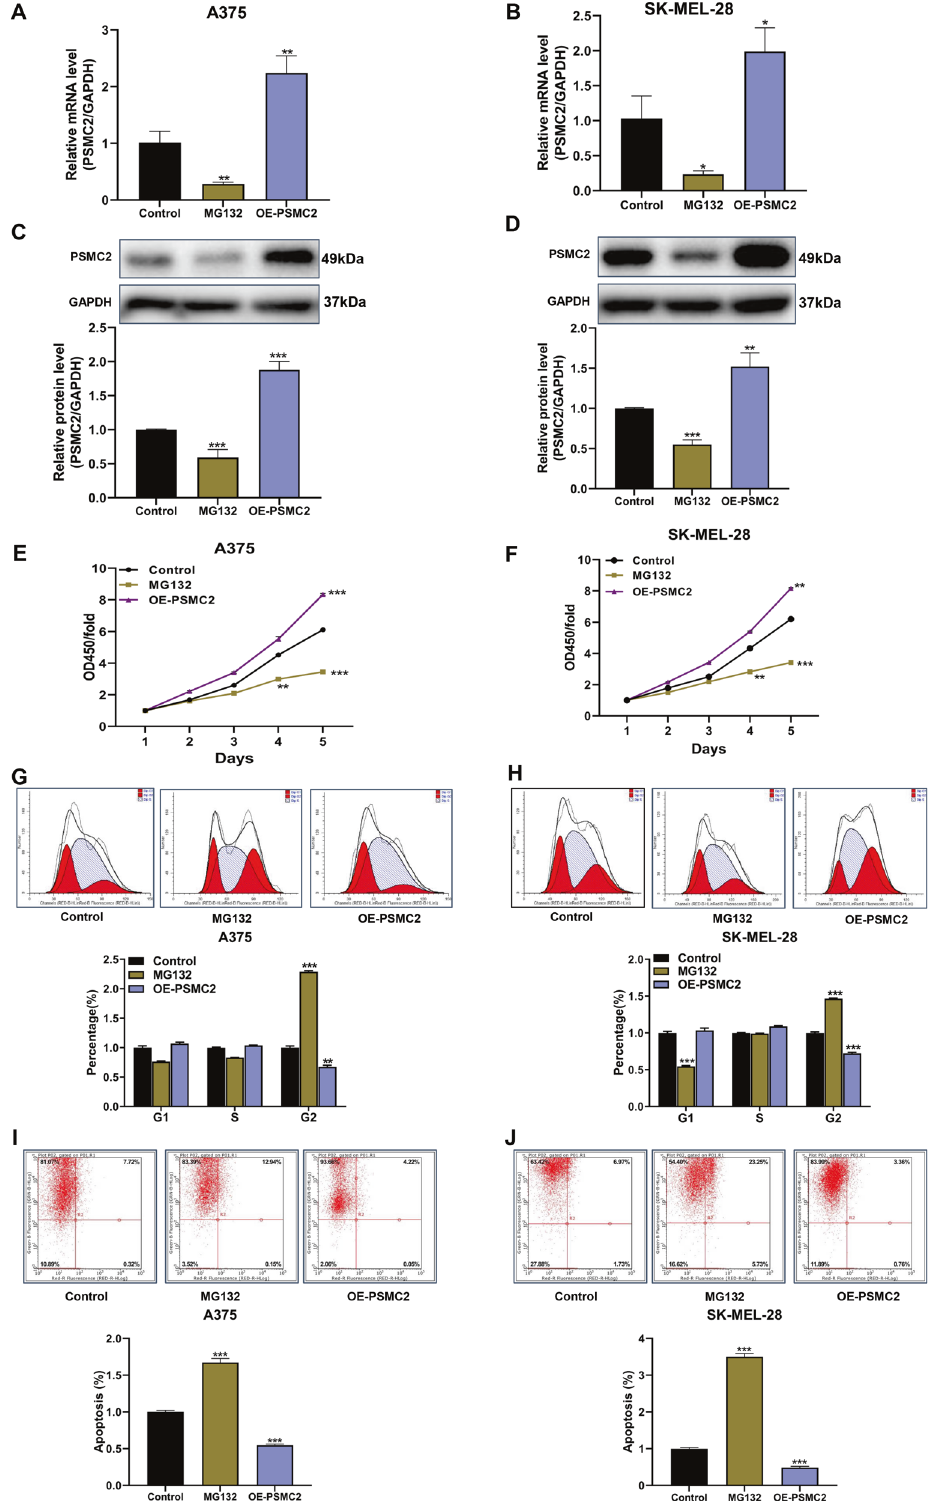
Fig. 5 The effect of inhibiting proteasome and exogenously enforced PSMC2 expression on cell proliferation, cell cycle and apoptosis. After treatment with MG132 or OE-PSMC2 plasmids, ( A , B ) The mRNA levels of PSMC2 were assessed by real-time PCR in A375 and SK-MEL-28 cells. C , D ) The protein levels of PSMC2 were determined by western blot in A375 and SK-MEL-28 cells. E , F The consequent in fl uences on SKCM cell proliferation of A375 and SK-MEL-28 cells were separately determined by the CCK-8 assay. G , H Flow cytometry analysis was used to evaluate the cell cycle progression and cell fractional quanti fi cation in the G0/G1, S, and G2/M phases were shown in the diagrams. I , J Apoptosis via quantifying Annexin FITC positive cells were shown and the apoptotic rate was calculated as the percentage of Annexin APC positive cells. Each independent experiment was repeated at least three times. Data were expressed as the mean ± SD. * p < 0.05, ** p < 0.01 and *** p < 0.001. Cell Death Discovery (2021)